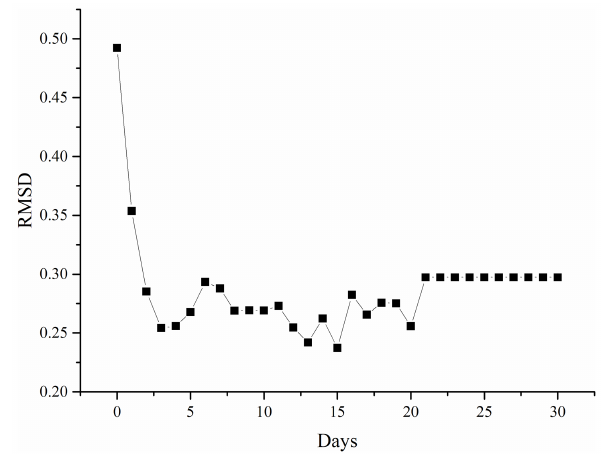
Figure 8. RMSD line of all grids depending on assimilation time. The TRIGRS model is assimilated with observations in the first 20 days, and results of days 21–30 are model running results with- out observations